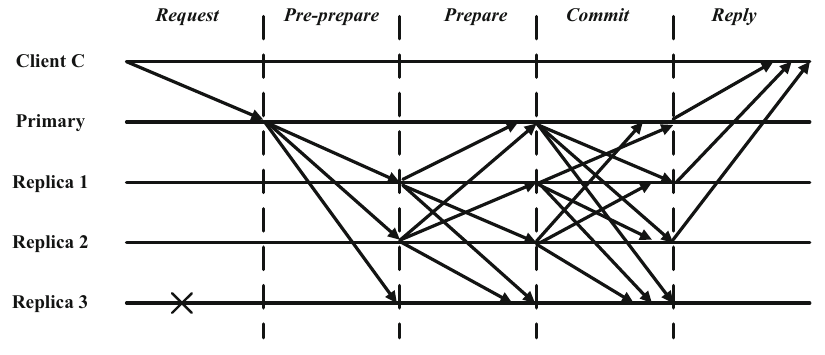
Fig. 1 PBFT consensus